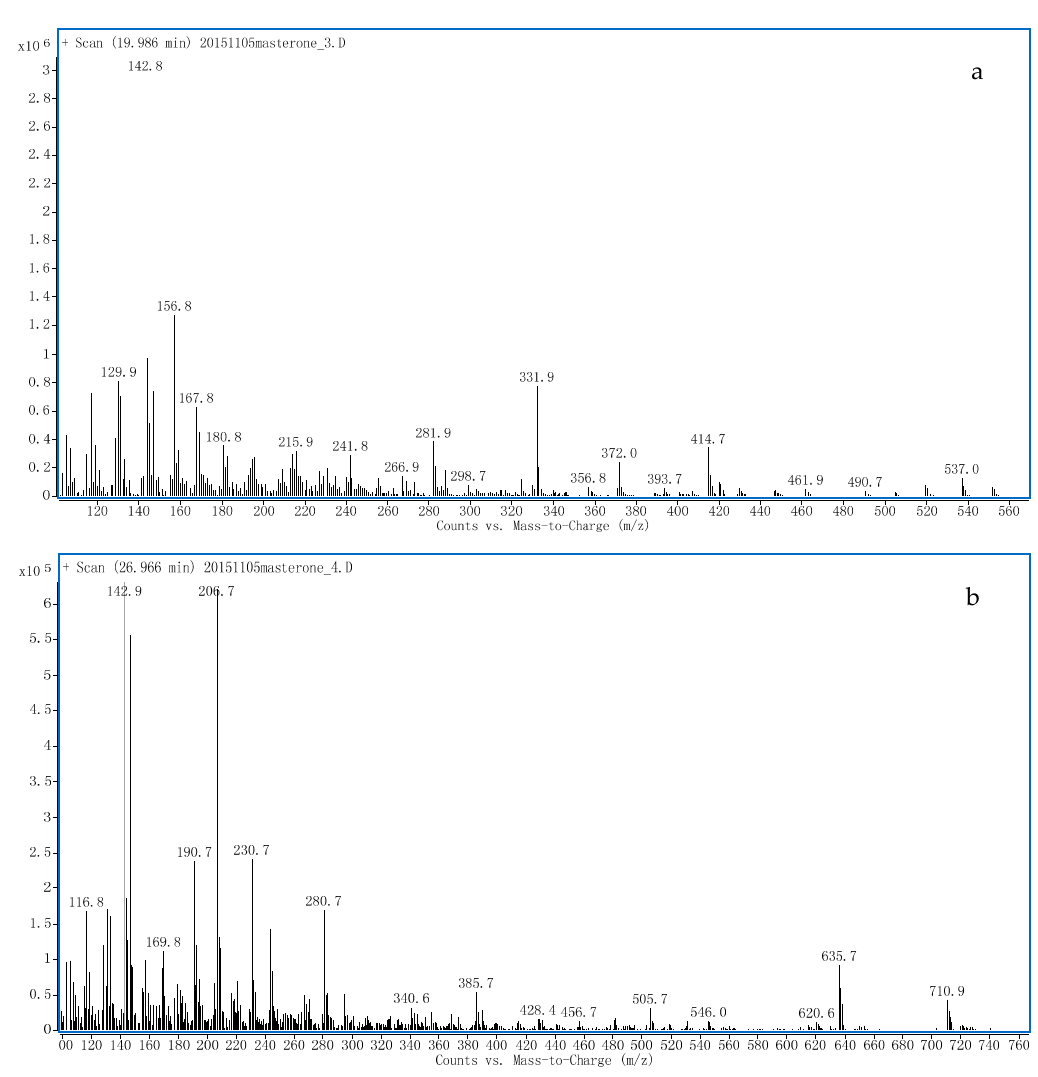
Figure 6. The Electron ionization mass spectra of TMS derivatives of: M4 ( a ); and M6 ( b ).